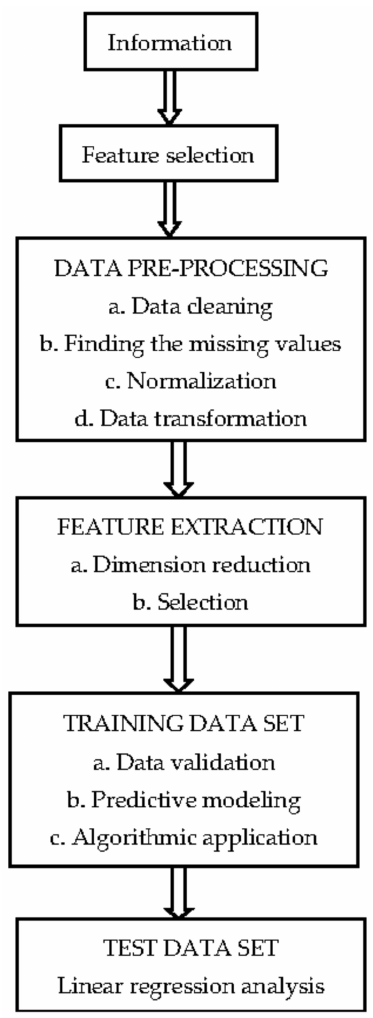
Figure 2. Process for estimating air